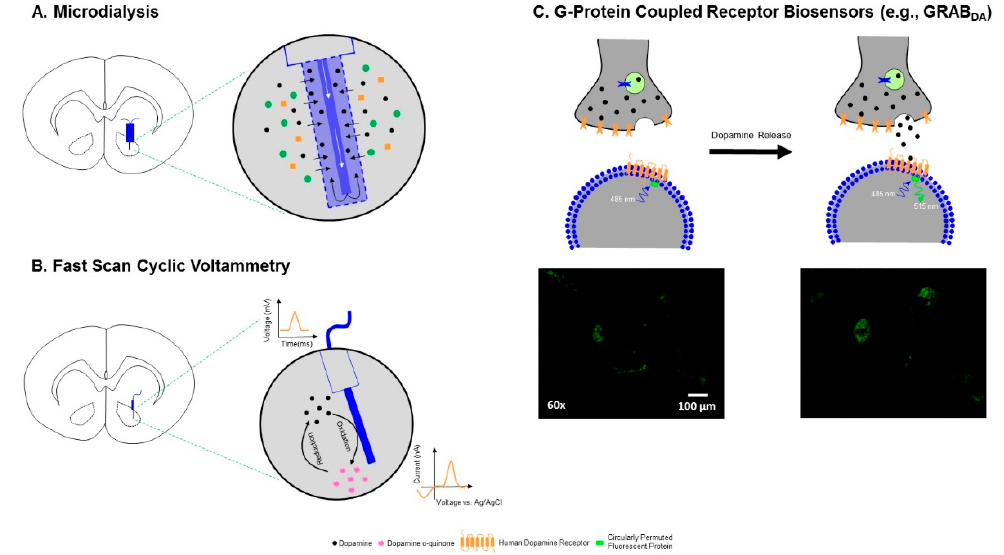
Figure 2. Technical illustration of three of the prominent methods utilized to detect dopamine (DA) levels in the CNS. Given that high-performance liquid chromatography (HPLC) is more classically used for analyte quantification on brain tissue homogenates or following microdialysis, the method is not illustrated. ( A ) During microdialysis, a probe composed of a semipermeable dialysis membrane is surgically implanted into the brain, and a perfusion medium (white arrows) is infused slowly and continuously. During perfusion, molecules in the extracellular space diffuse through the semipermeable membrane, and are transported into outflow tubing and collected for analyte quantification (e.g., HPLC). ( B ) In fast-scan cyclic voltammetry, a small carbon-fiber microelectrode is surgically implanted into the brain. The voltage potential at the carbon-fiber microelectrode is rapidly increased and decreased, resulting in the oxidation and reduction of DA. During the oxidation and reduction processes, the transfer of electrons is measured in current at the surface of the carbon-fiber microelectrode, and the amount of current can be subsequently converted into the concentration of DA. Additionally, the voltammogram is used for analyte identification, whereby DA exhibits one oxidation and one reduction peak. ( C ) More recently, G-protein coupled receptor (GPCR) biosensors for DA have been developed, affording an opportunity to track the release dynamics of DA. DA biosensors have a circularly permuted fluorescent protein (e.g., Green: cpGFP, Red: cpmApple) inserted into the third intracellular loop of the DA receptor. When DA binds to the endogenous ligand, the GPCR exhibits a conformational change, resulting in an increased fluorescent intensity. Our laboratory has recently transfected cells with GRAB-DA2m, a DA receptor 2 subtype biosensor, in vitro. Upon stimulation with 100 nm DA, an increase in the fluorescence intensity of cpGFP is observed.